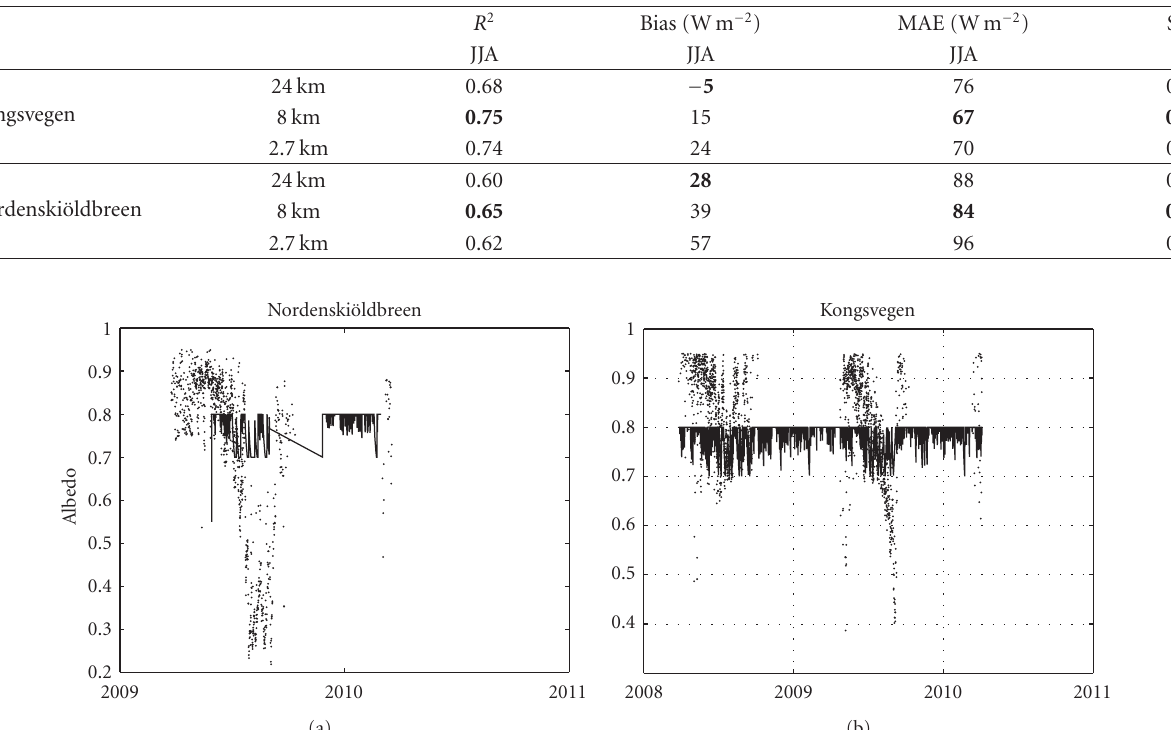
Table 6: Statistical evaluation of incoming short-wave radiation in summer 2009. Bold numbers indicate the best result for each AWS. Vestfonna data are not used here because of the lack of data during the chosen period.